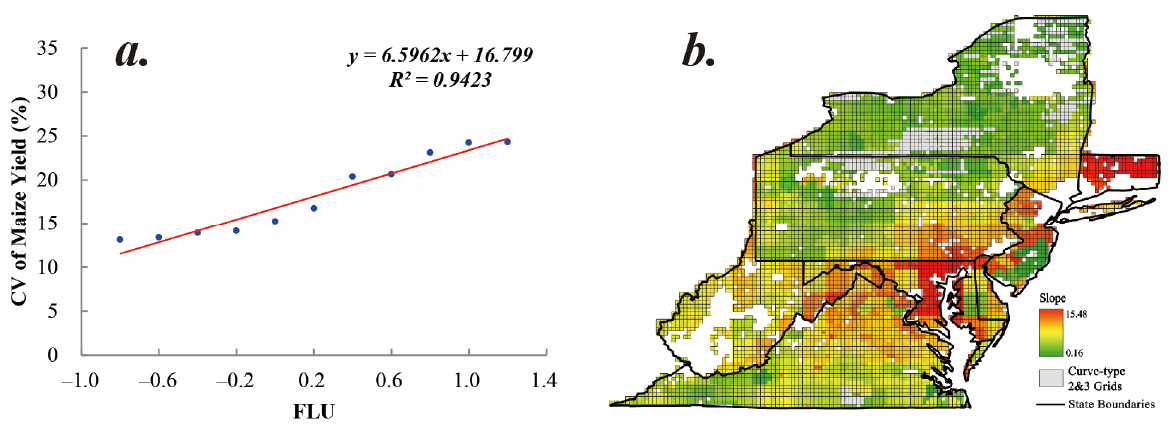
Figure 5. Type I vulnerability curve ( a ) and its slope distribution pattern ( b ).